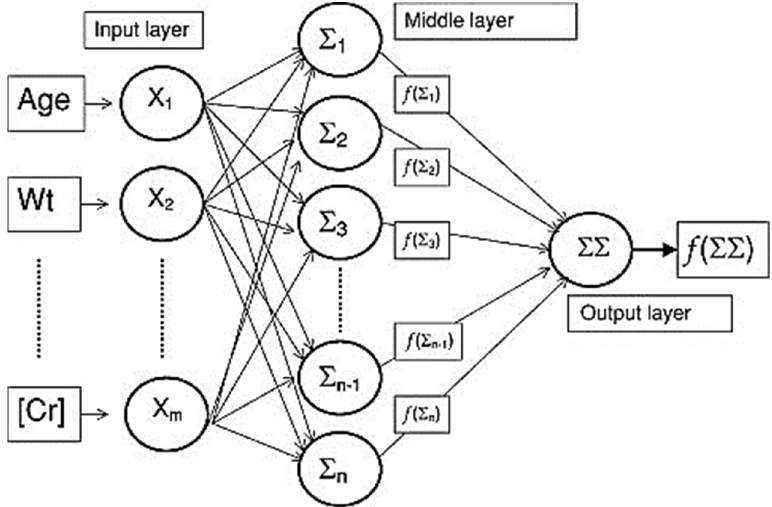
Figure 3. Architecture of ANN.